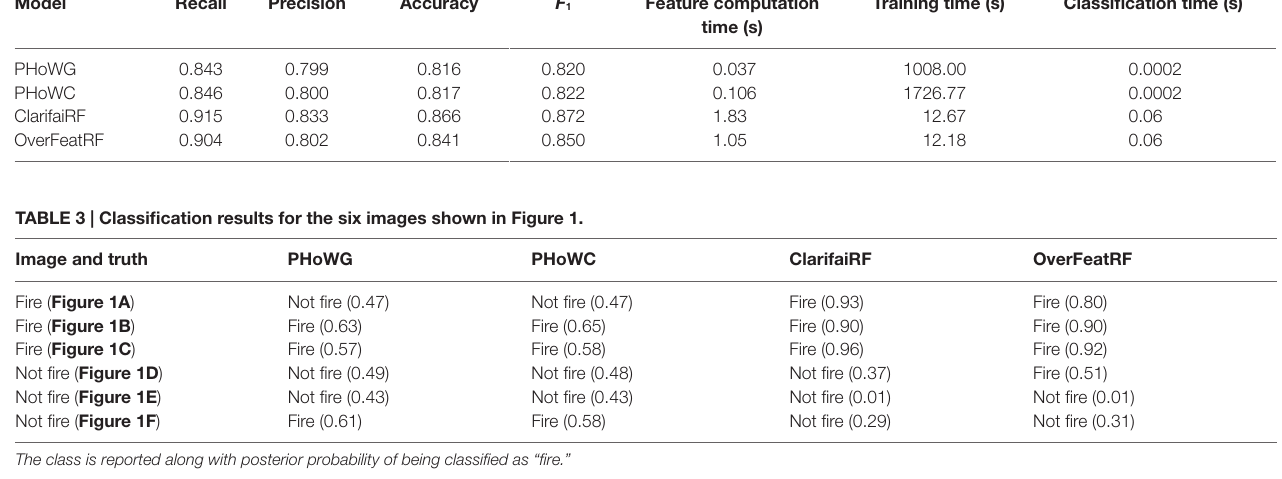
TABle 2 | performance results for the four classification approaches.